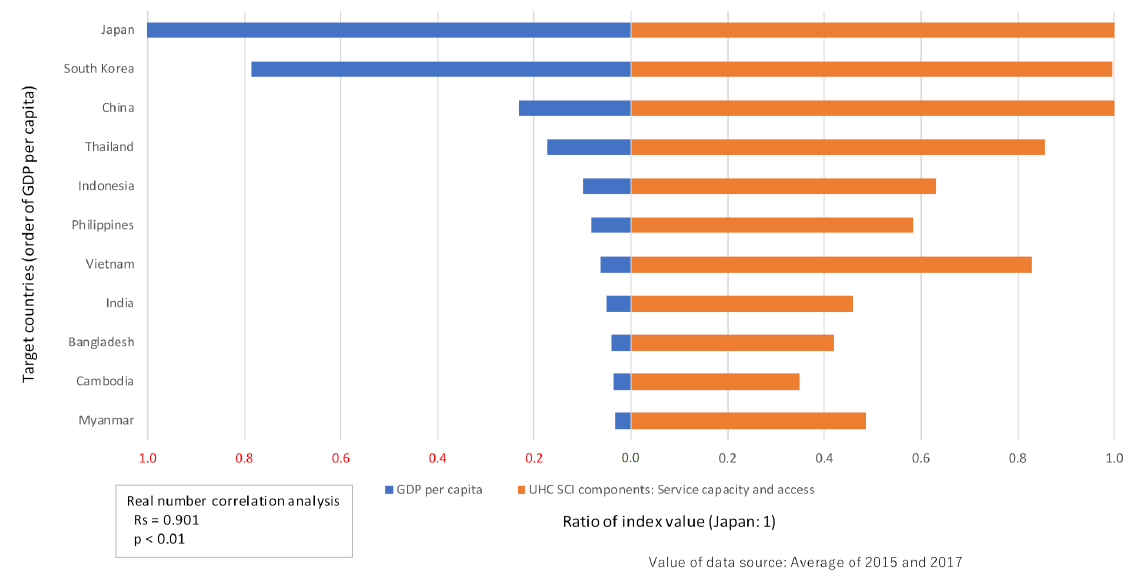
Figure 3. Trends of country-specific economic levels (GDP) and SCI components (service capacity and access). Note: UHC, universal health coverage; SCI, service coverage index.